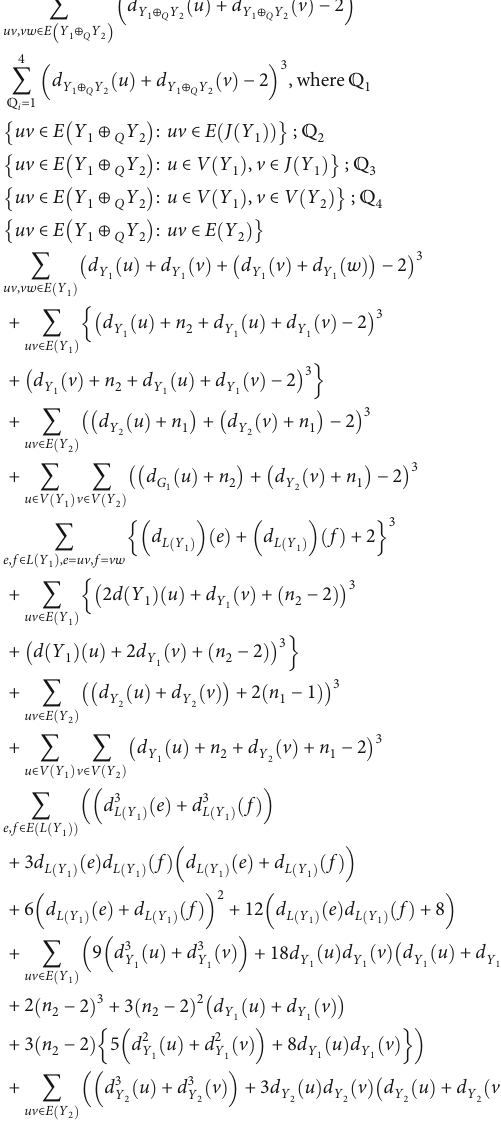
Table 6: The degree distribution of Y